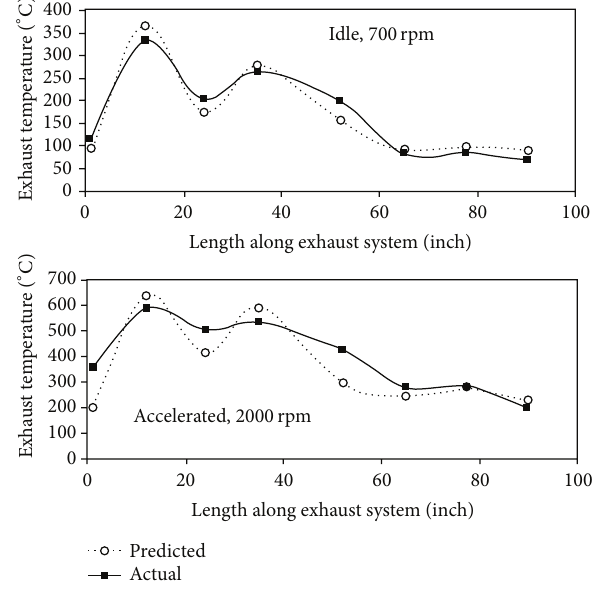
Figure 4: Illustration of the exhaust gas temperature versus tailpipe length